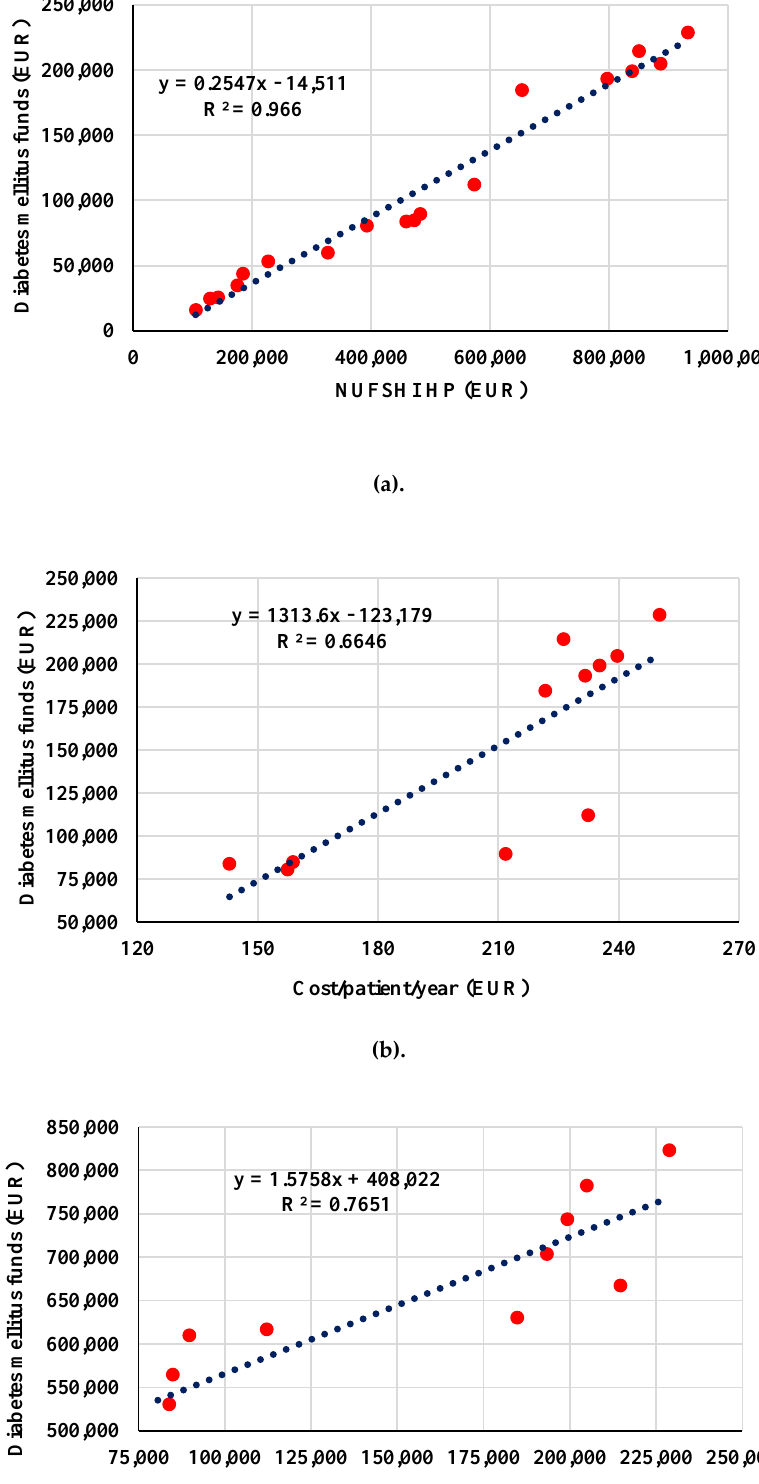
Figure 7. Association between DMF and NUFSHI HP ( a ), Cost/patient/year ( b ) and Number of patients ( c ).